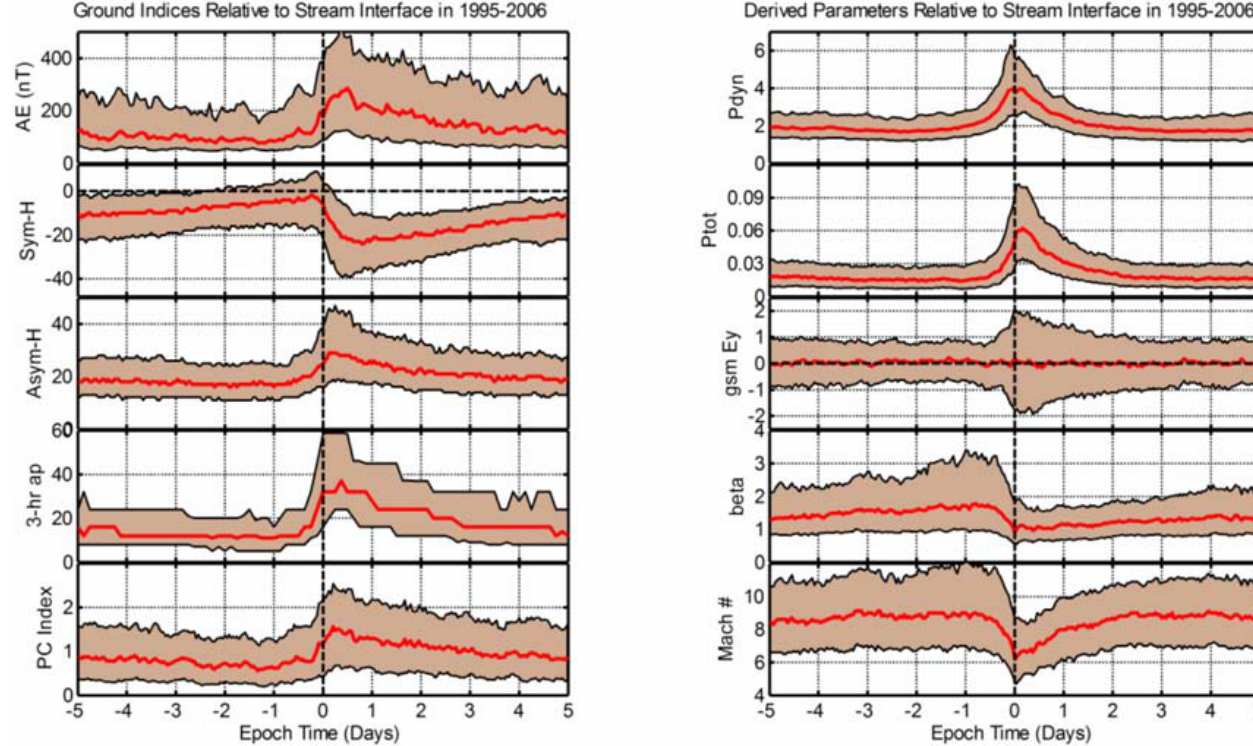
Fig. 1. Results of superposed epoch analysis of solar wind and magnetospheric parameters are plotted versus time relative to a stream interface at the center of a corotating interaction region (CIR). The five panels on the right respectively show solar wind dynamic pressure, total of thermal and magnetic pressure, gsm E y , plasma beta, and plasma Mach number. The five panels on the left show the AE index, the Sym-H index, the Asym-H index, the 3-h A p index and the PC index. Heavy black lines at the edges of the shaded regions define the range within which 50% of the data lie. The heavy red line at the center of shaded regions defines the parameter median at each epoch.